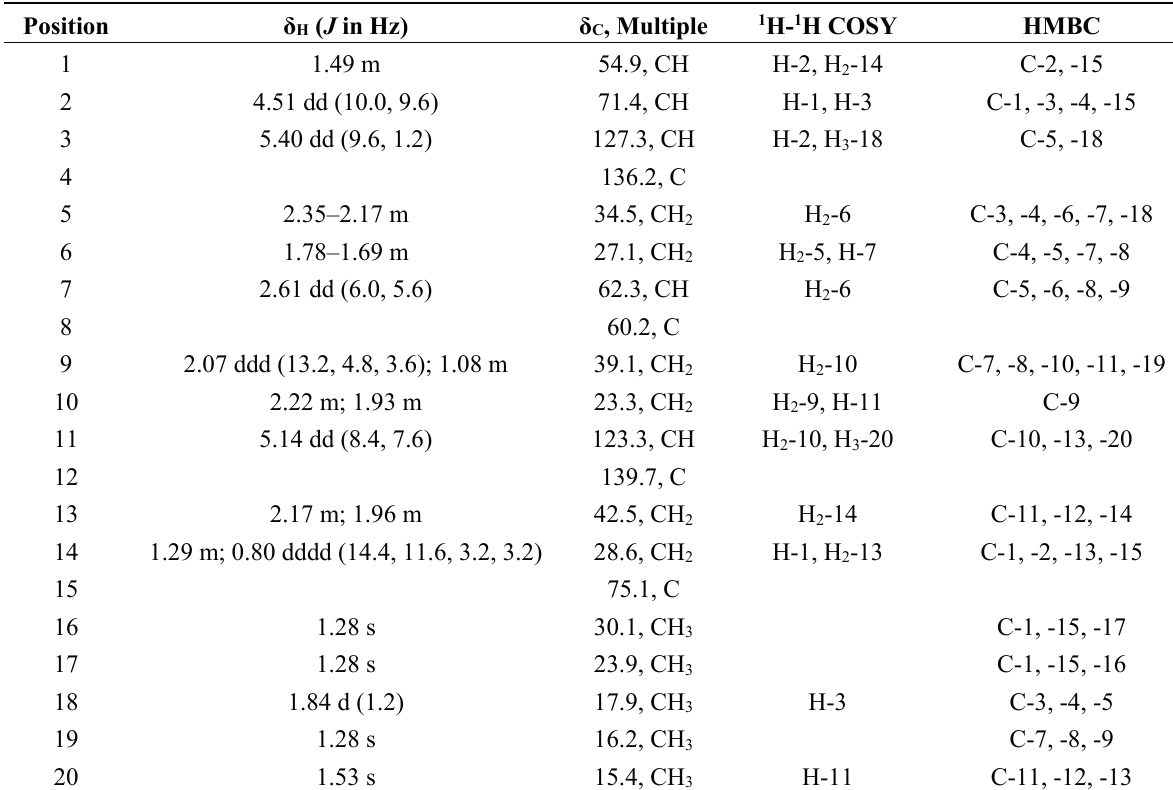
Table 1. 1 H (400 MHz, CDCl 3 ) and 13 C (100 MHz, CDCl 3 ) NMR data, 1 H- 1 H COSY and HMBC correlations for cembrane 1